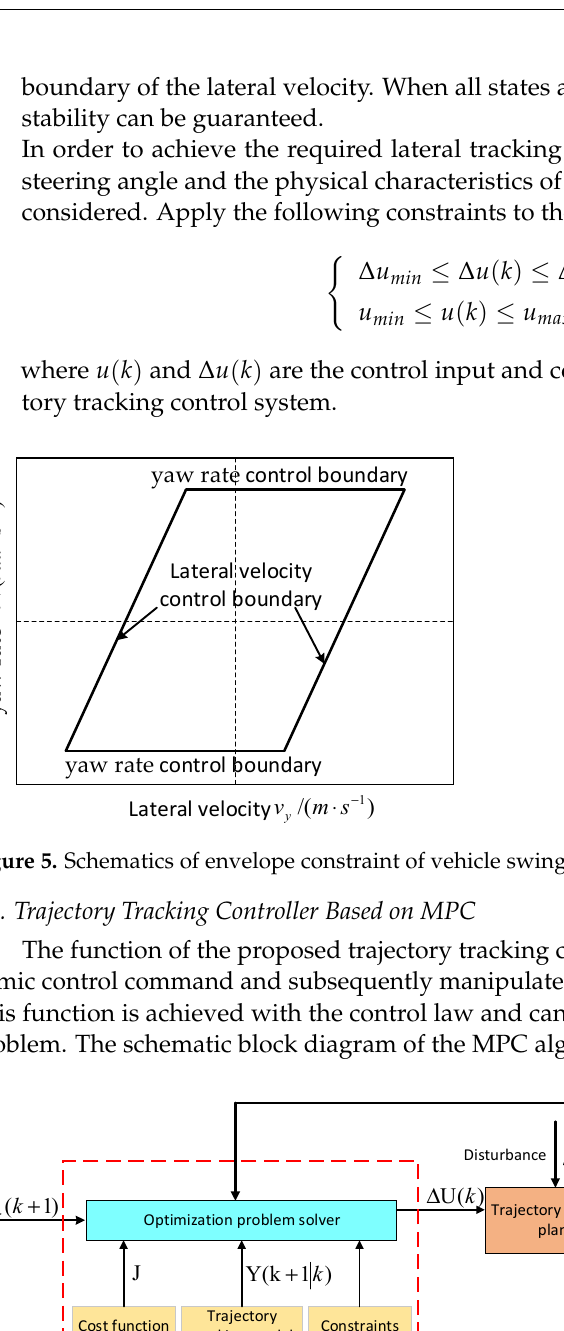
Figure 6. Schematic block diagram of the proposed MPC algorithm.